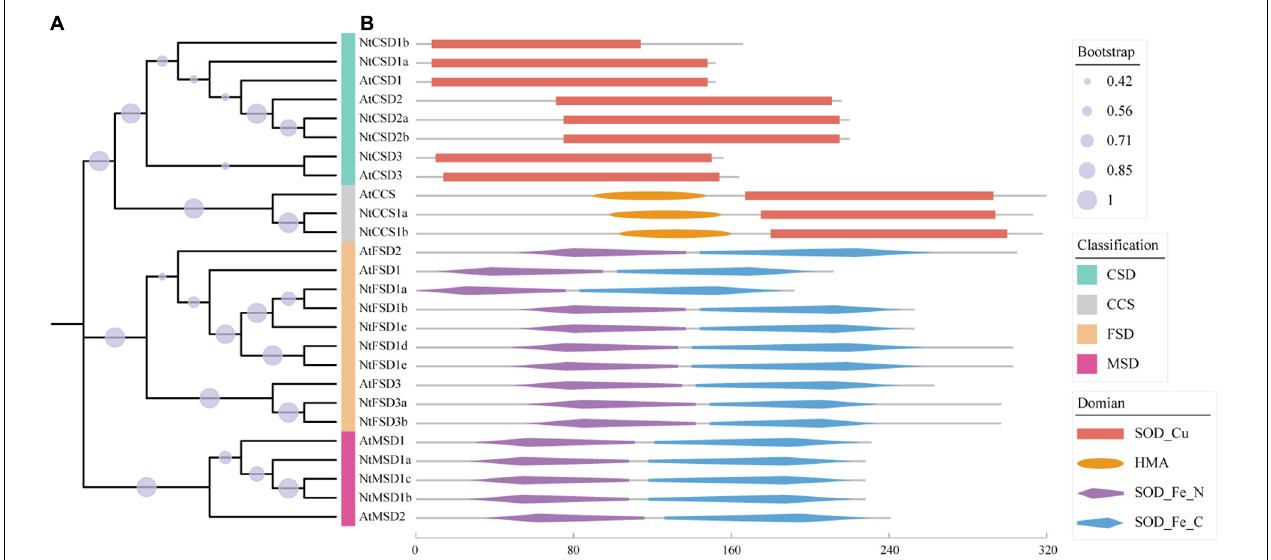
FIGURE 1 | Phylogenetic analysis and distribution of conserved structural domains of SOD gene family members in N. tabacum and Arabidopsis . (A) Phylogenetic tree of AtSODs and NtSODs. (B) Distribution of conserved structural domains of AtSODs and NtSODs. Red squares indicate the SOD_Cu structural domain (PF00080), orange oval blocks indicate the HMA structural domain (PF00403), and purple and blue diamond blocks represent the SOD_Fe_N structural domain (PF00081) and SOD_Fe_C structural domain (PF02777),